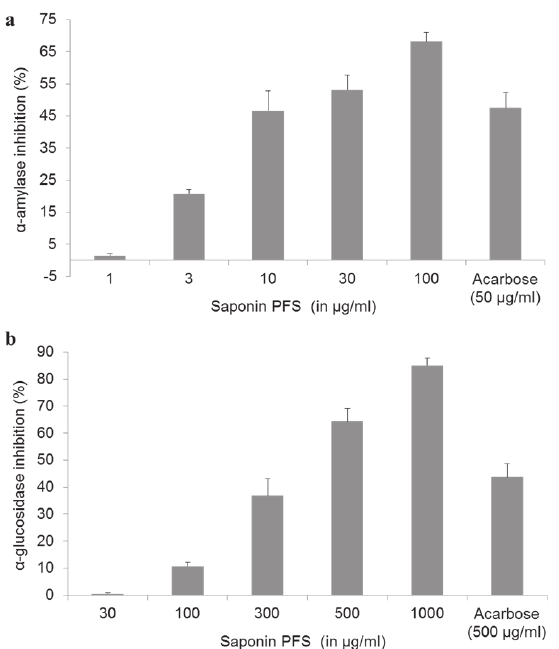
Figure 2 - Inhibitory effect of saponin PFS against α -amylase ( a ) and α -glucosidase ( b ). Acarbose was used as a reference at 50 µg/ml for α -amylase and 500 µg/ml for α -glucosidase assay. Bars represent standard deviations of triplicate measurements.